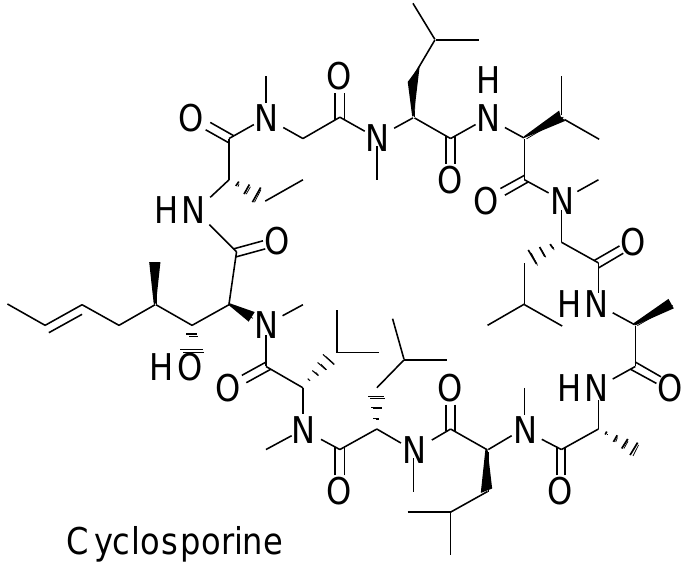
Figure 3. Structure of cyclosporine as N -methylated macropeptide.